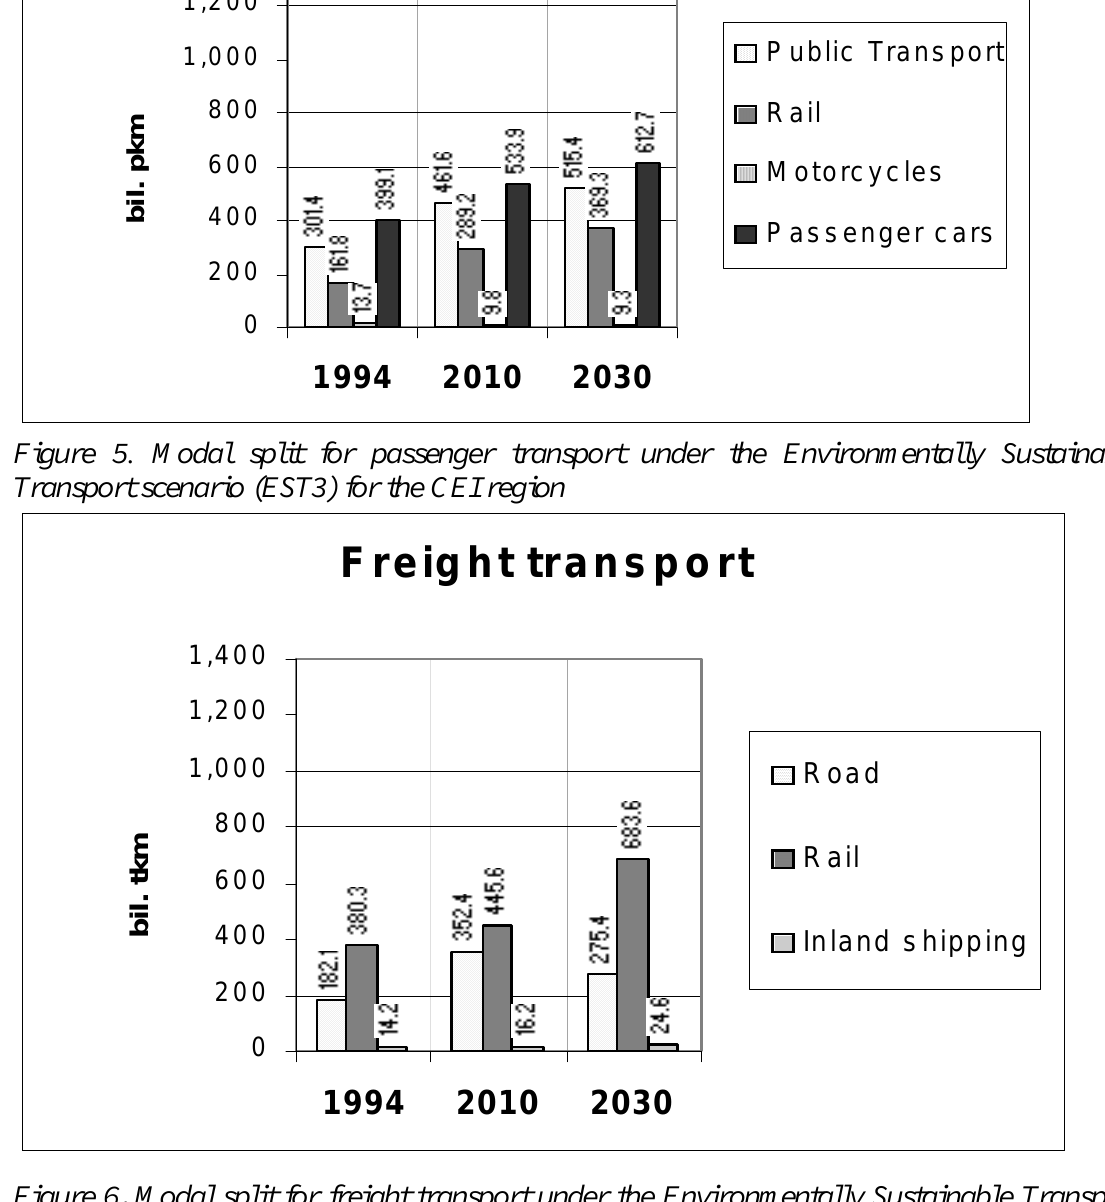
Figure 6. Modal split for freight transport under the Environmentally Sustainable Transport scenario(EST3) for the CEI